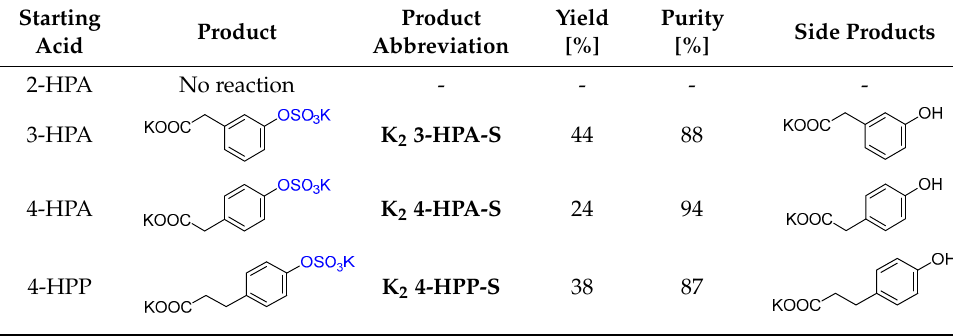
Table 1. Chemical sulfation by SO 3 ·pyridine in pyridine.